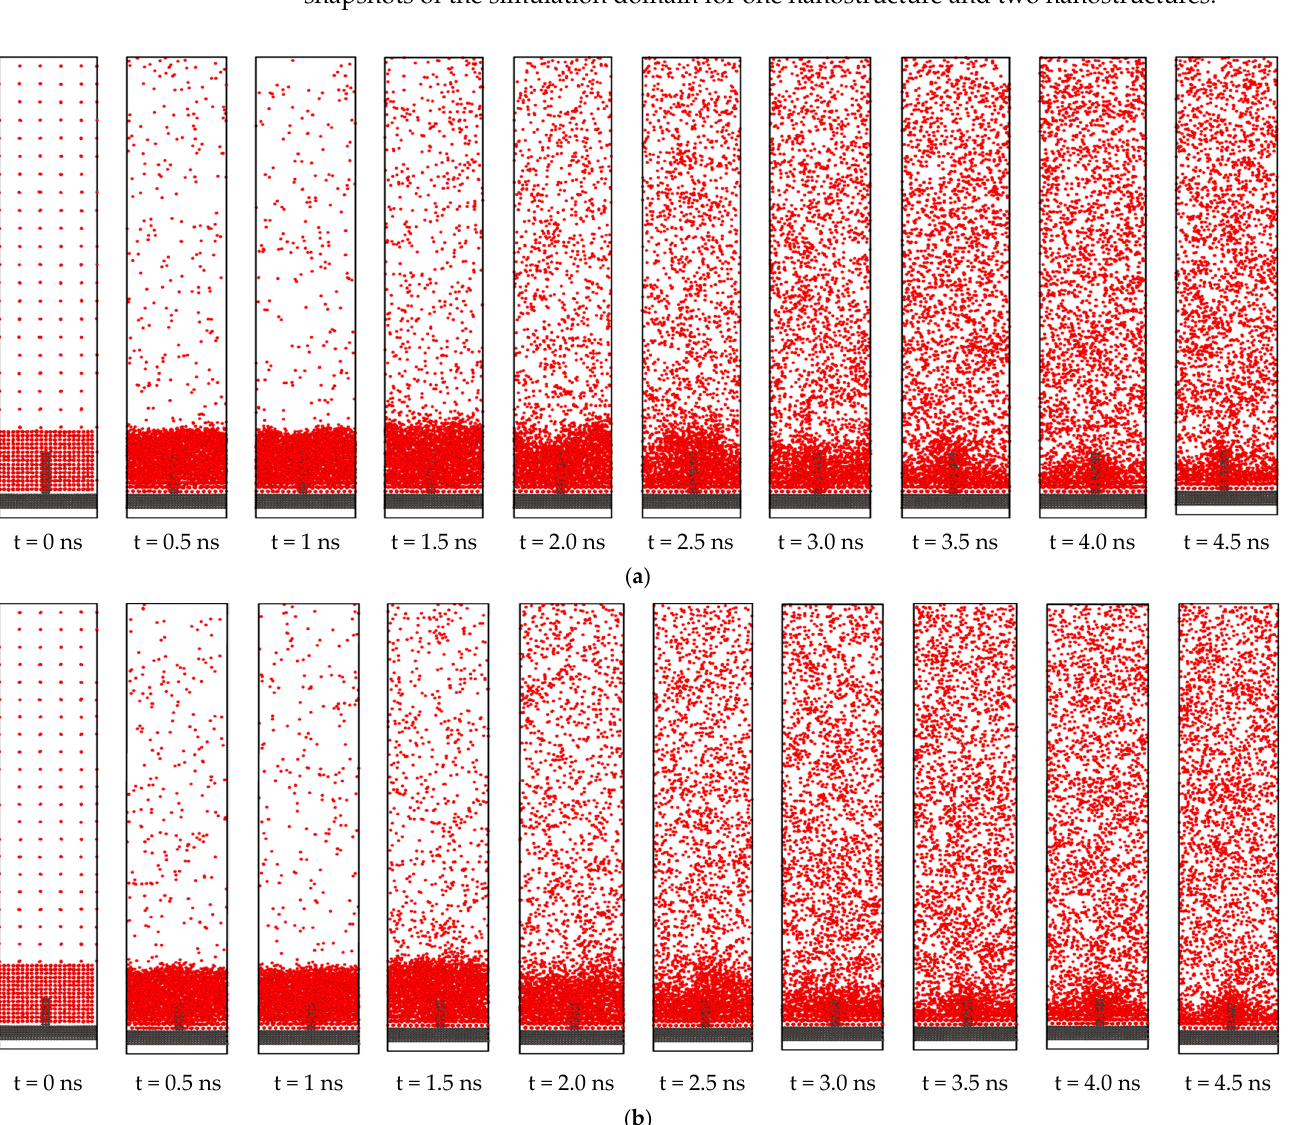
Figure 22. Snapshots from the simulation domain ( x – y plane) for ( a ) one nanostructure, ( b ) two nano structures.